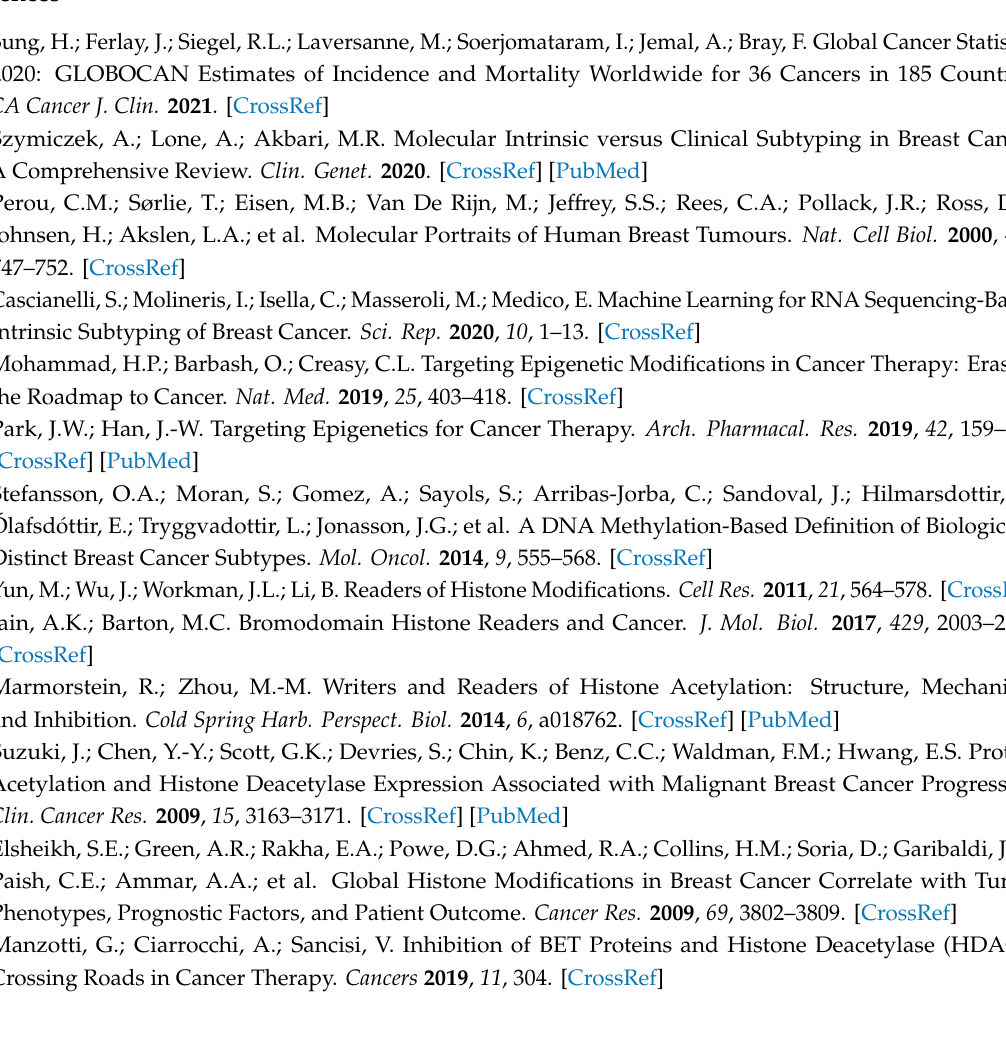
Figure S1: Expression of the eight HAM signature genes in normal breast tissues and breast cancers with four PAM50 intrinsic molecular subtypes, Figure S2: Volcano plot of di ff erentially expressed genes between HAM1 and HAM2 groups, Table S1: HAM group classification result for each TCGA sample, Table S2: List of di ff erentially expressed genes between HAM1 and